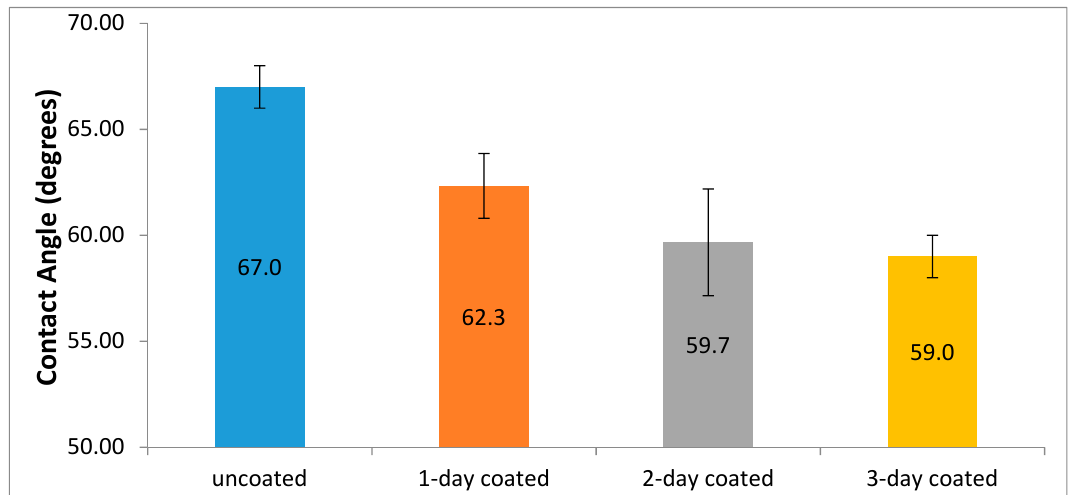
Figure 3. The contact angles of the uncoated and the coated membranes.